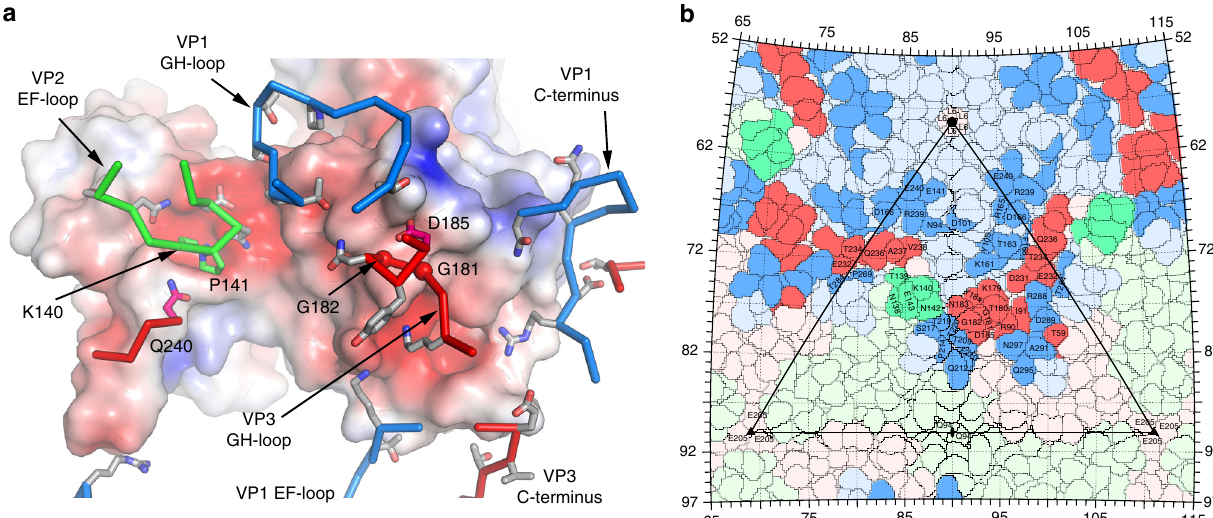
Fig. 5 Comparison of amino acids in the receptor attachment area of CV-A10 strains and with other enteroviruses that cause HFMD. a Residues in 14 strains of CV-A10 are highly conserved (33 out of 37) and 6 of the 31 residues are conserved among the KRM1-dependent type A enteroviruses, these are K140 and P141 in VP2 EF loop, G181, G182 and D185 in the VP3 GH loop, and Q240 at the C-terminus of VP3. Only one residue VP3 Q240 is conserved among 19 HFDV causing enteroviruses. KRM1 is shown as an electrostatic surface, residues of CV-A10 involved in contacts are shown as sticks with the same colour scheme as Fig. 3d, except the non-conserved sidechains are in grey. b Roadmap depiction of the virus surface (see “ Methods ” section). An icosahedral subunit is outlined in black lines and residues from VP1 are shown in blue, VP2 green and VP3 red with those in contact with KRM1 highlighted in the corresponding protein colour. Residues in contact with KRM1 and around the icosahedral symmetry axis are